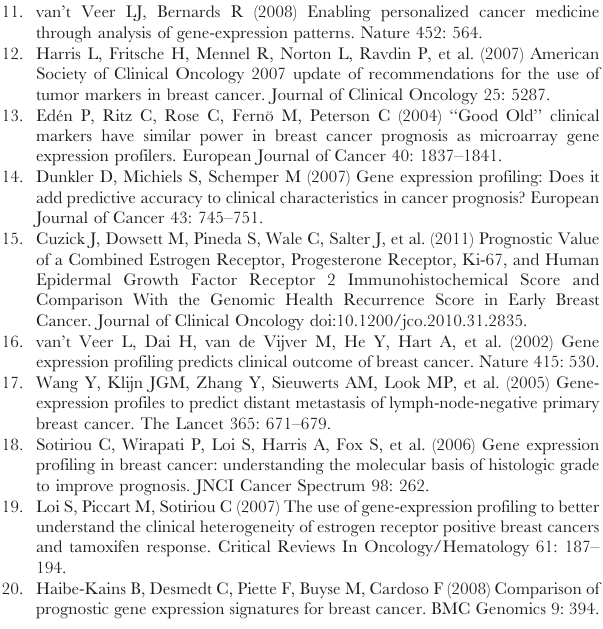
Table S1 An Excel workbook that records the gene sets detected by the partition-based algorithm applied to the UPPSALA data with partition size= 129, and tolerance for mismatch = 17. Table S2 An Excel workbook that records all of the gene sets detected in the UPPSALA data. File S1 An Excel workbook with twenty-four spread sheets which record Cox proportional hazards models (six worksheets for each of four datasets). Each sheet contains six to twelve or more models grouped by domain (all samples, estrogen-positive samples, estrogen-negative samples) and by follow-up (censored at five years and full